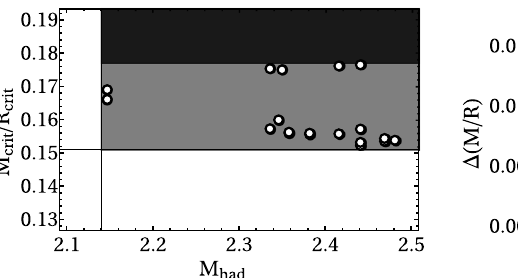
Each black hollow dot denotes a given EoS. (Right panel) Plot shows the variation of Δ( M / R ) as a function of M crit / R crit for different EoS and the obtained fit for PT from NS to